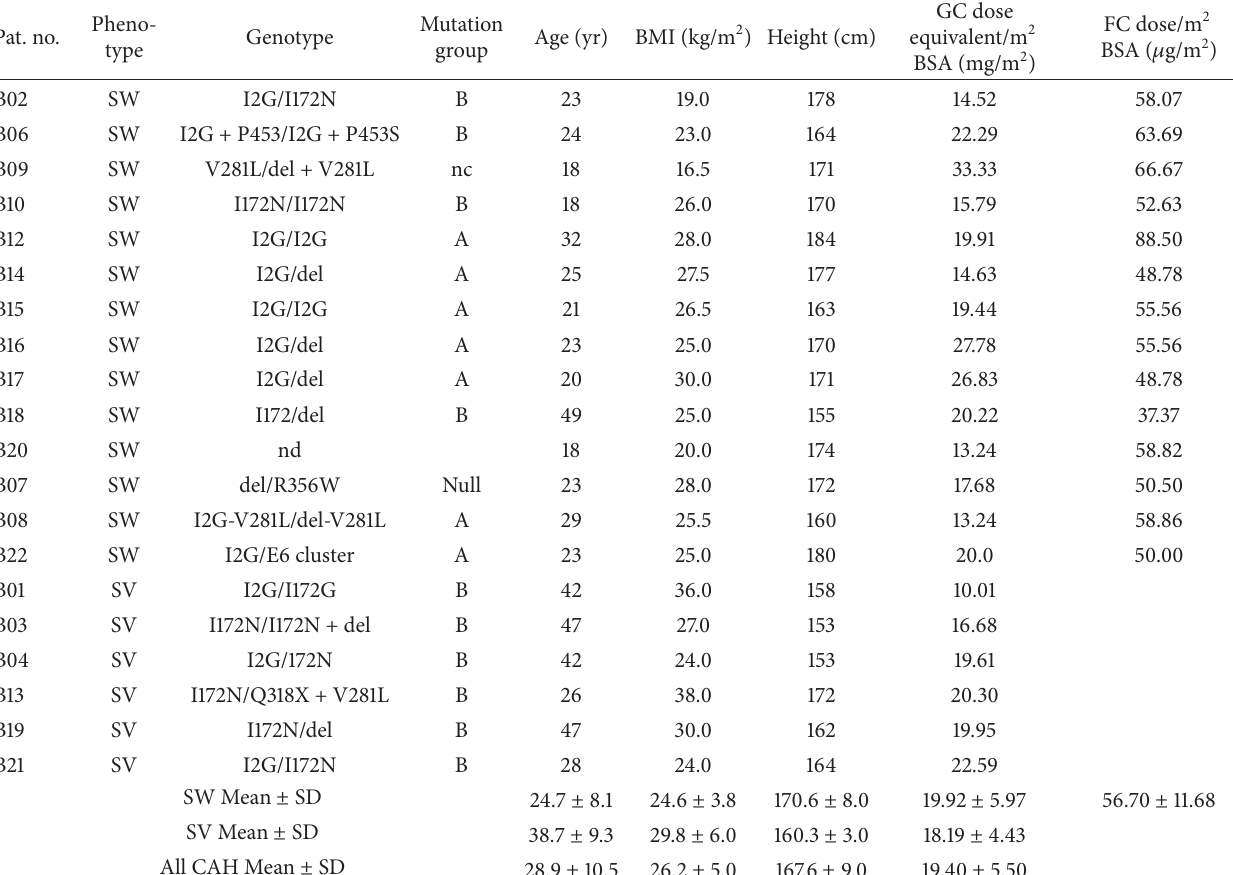
Table 1: Clinical and genetic characteristics of 20 male patients with 21-OHD at study start (baseline). Pat.